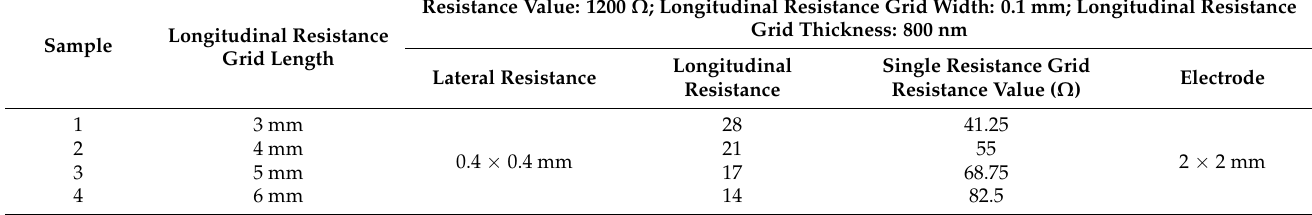
Table 14. Geometrical dimensions of thin-film sensor with different length of resistance grid.